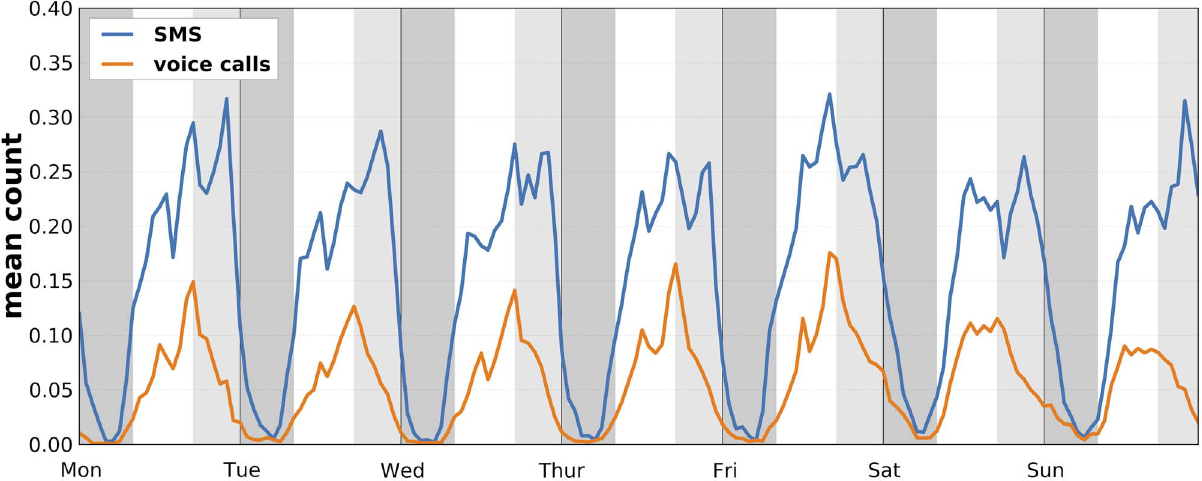
Figure 10. Weekly temporal dynamics of interactions. All calls and SMS, both incoming and outgoing, were calculated over the entire dataset and averaged per participant and per week, showing the mean number of interactions participants had in a given weekly bin. Light gray denotes 5pm, the time when lectures end at the university, dark gray covers night between 12 midnight and 8am. SMS is used more for communication outside regular business hours.